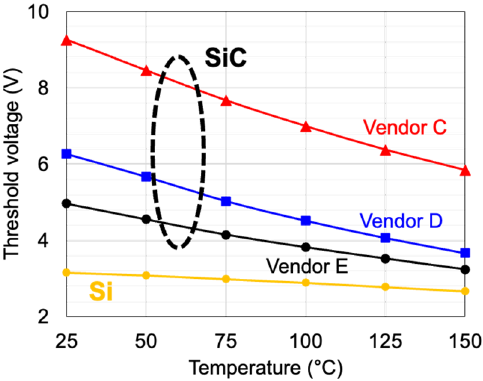
Figure 3. Typical threshold voltage versus temperature curves in SiC MOSFETs from different ven- dors.